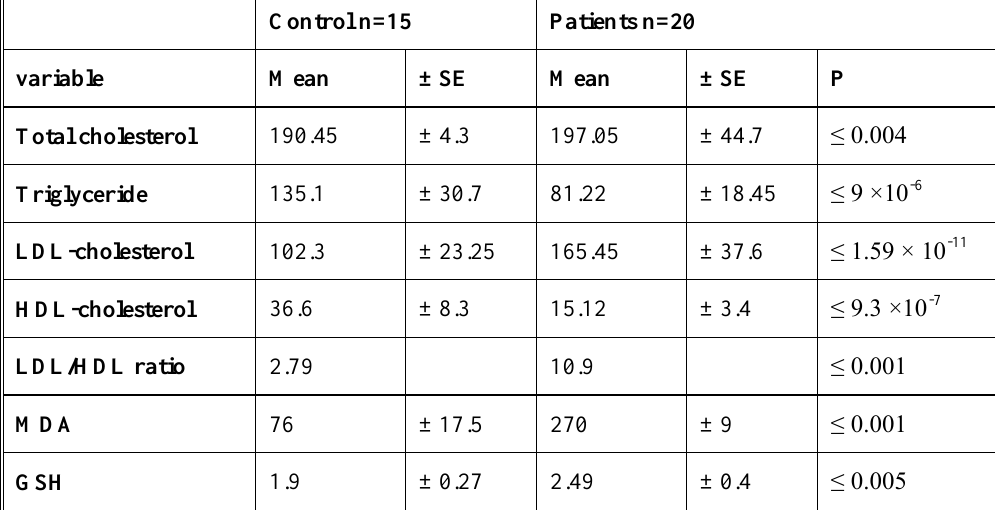
Table 1 : Mean±SE (mg/dl) of serum lipid profile (total cholesterol, LDL-cholesterol, Triglyceride, HDL-cholesterol, Malondialdehyde and Glutathione) levels (nmol/l) and LDL/HDL ratio in patients with brucellosis and control